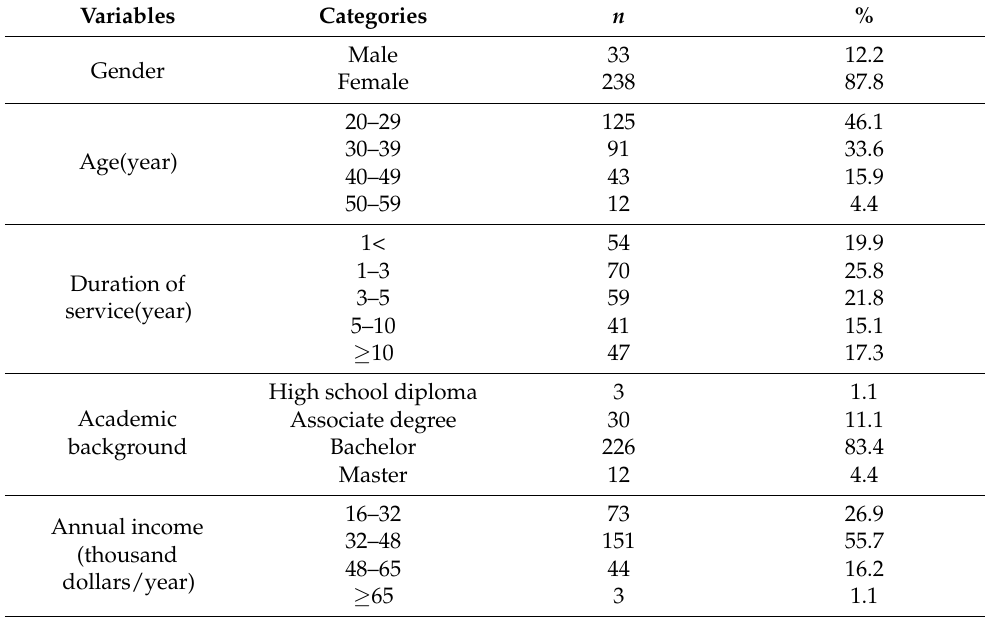
Table 1. General characteristics of the study